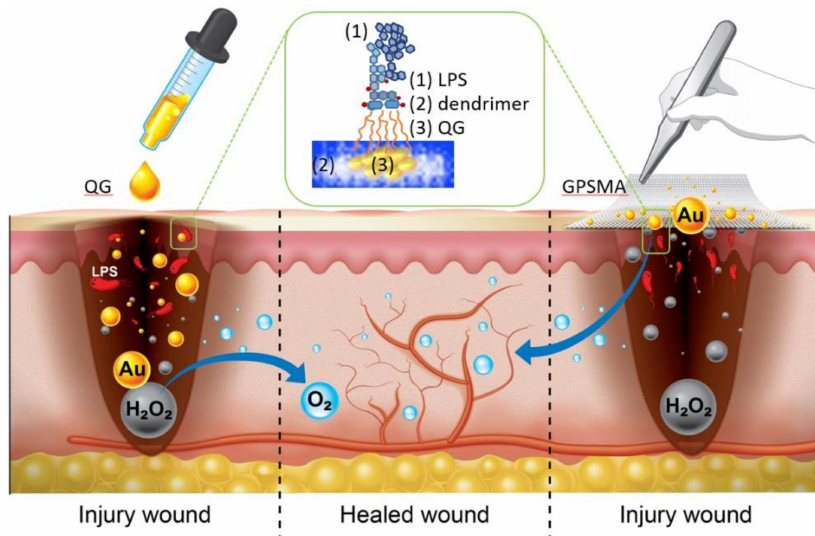
Figure 1. Schematic illustration of the impacts of a liquid form of quantized gold (QG) and a dressing form consisting of QG-grafted PSMA nanofibers (GPSMA) for the promotion of wound healing. The green rectangle shows the adhesive mechanism between QG and lipopolysaccharides